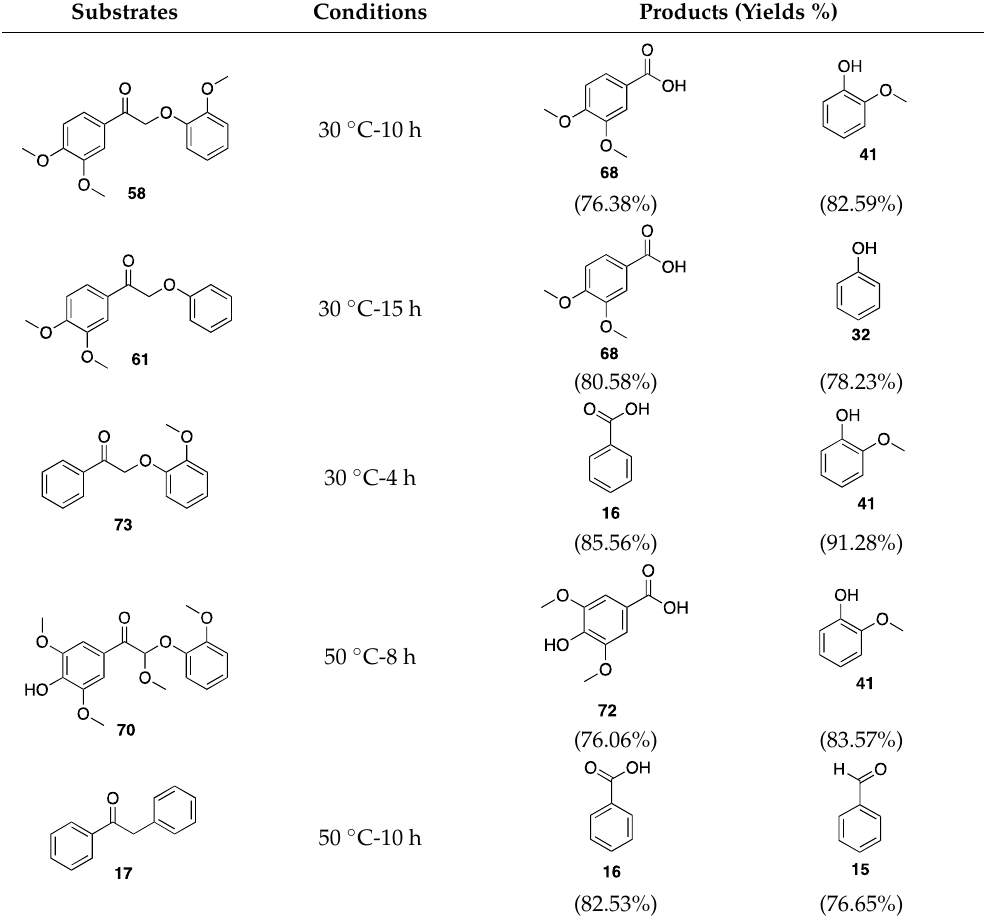
Table 3. Scope of the reaction.